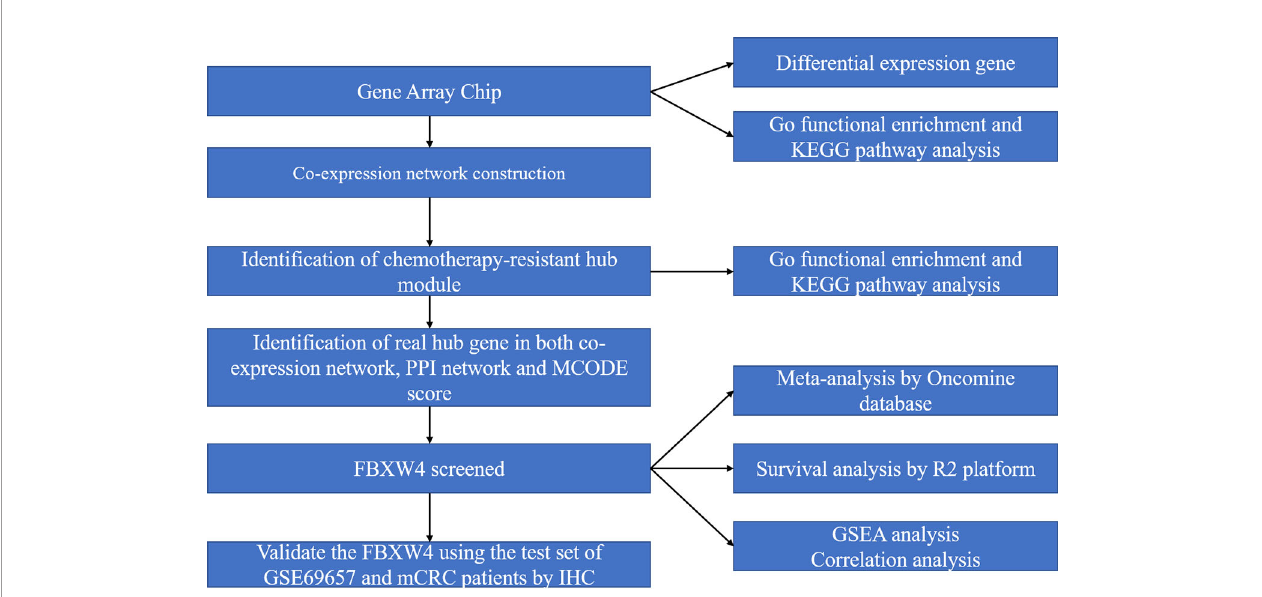
FIGURE 1 | Work fl ow diagram of data preparation, processing, analysis, and validation in this study. FBXW4, F-box/WD-40; GO, Gene Ontology; GSEA, gene set enrichment analysis; PPI, protein-protein interaction; MCODE, Molecular Complex